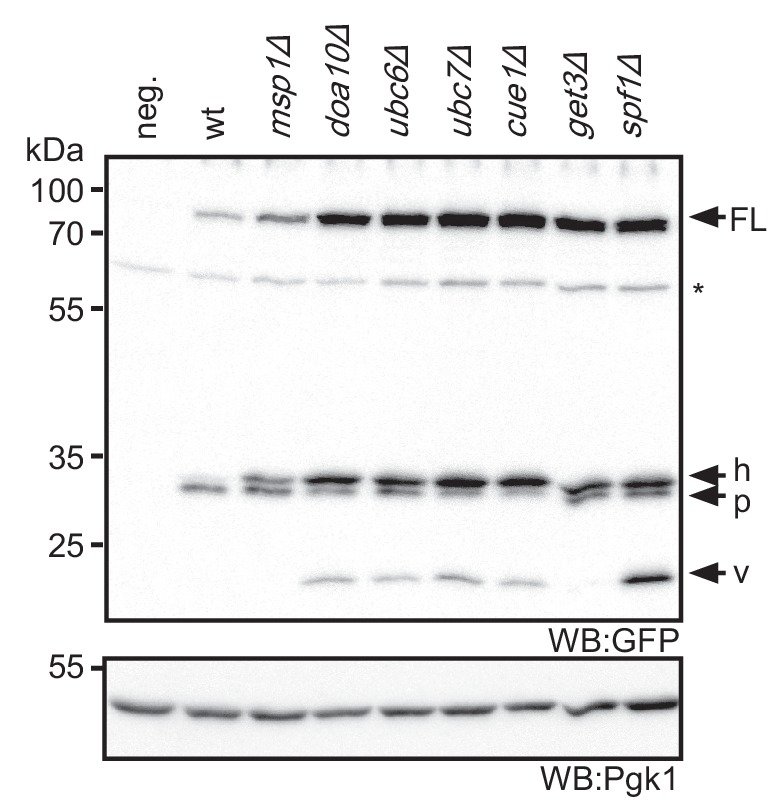
Steady state level of tFT-Pex15Δ30 in yeast mutants.Lysate of wt yeast and indicated mutants probed with anti-GFP antibody to reveal full length tFT-Pex15Δ30 (FL) and degradation resistant tFT intermediates (h, p, v, see Figure 2B for further explanation). WB, western blot. Unspecific bands are marked with star. Pgk1 serves as loading control.